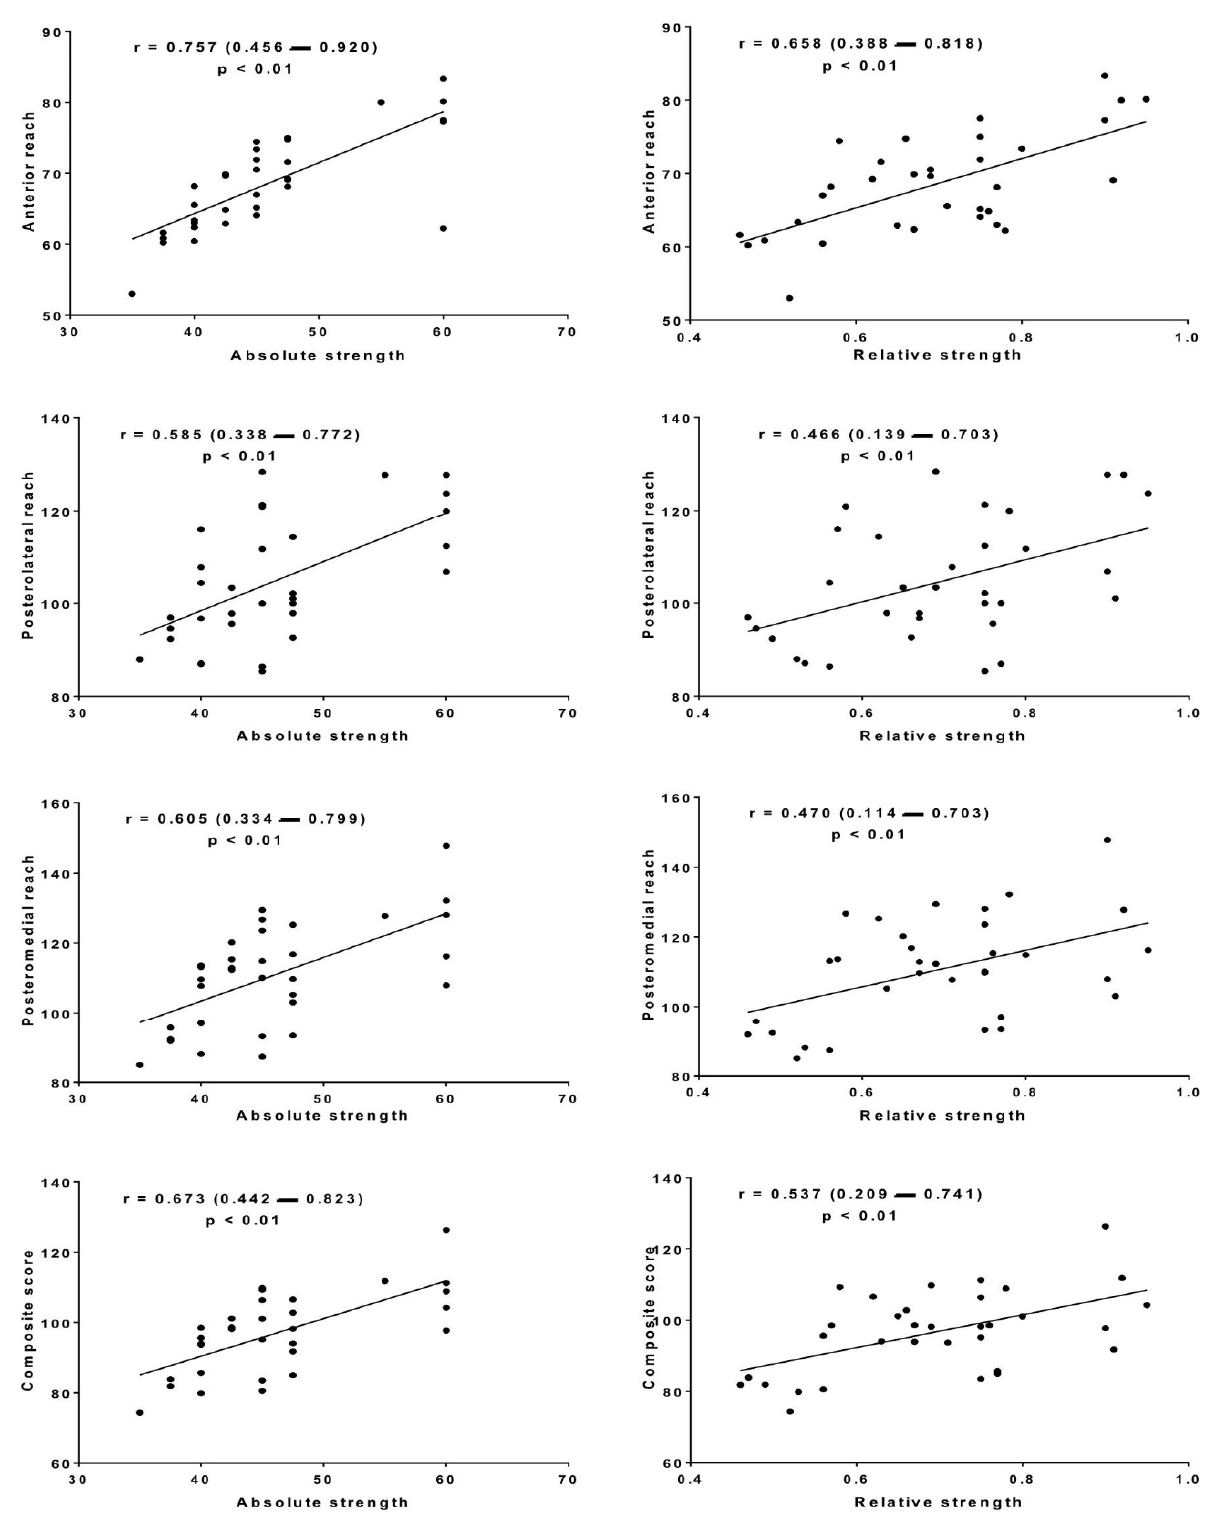
Figure 1. Scatter plots for unilateral leg extension strength (absolute and relative) and Y Balance Test 3 directions, and as well as composite scores and linear regression line with 95% CI.